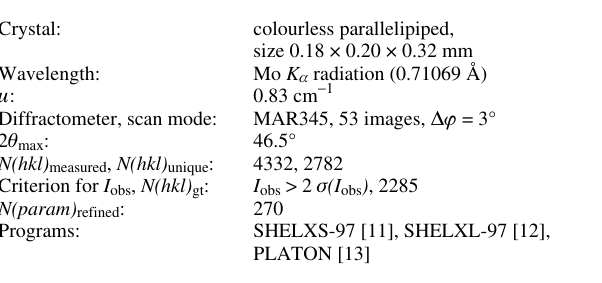
Table 1. Data collection and